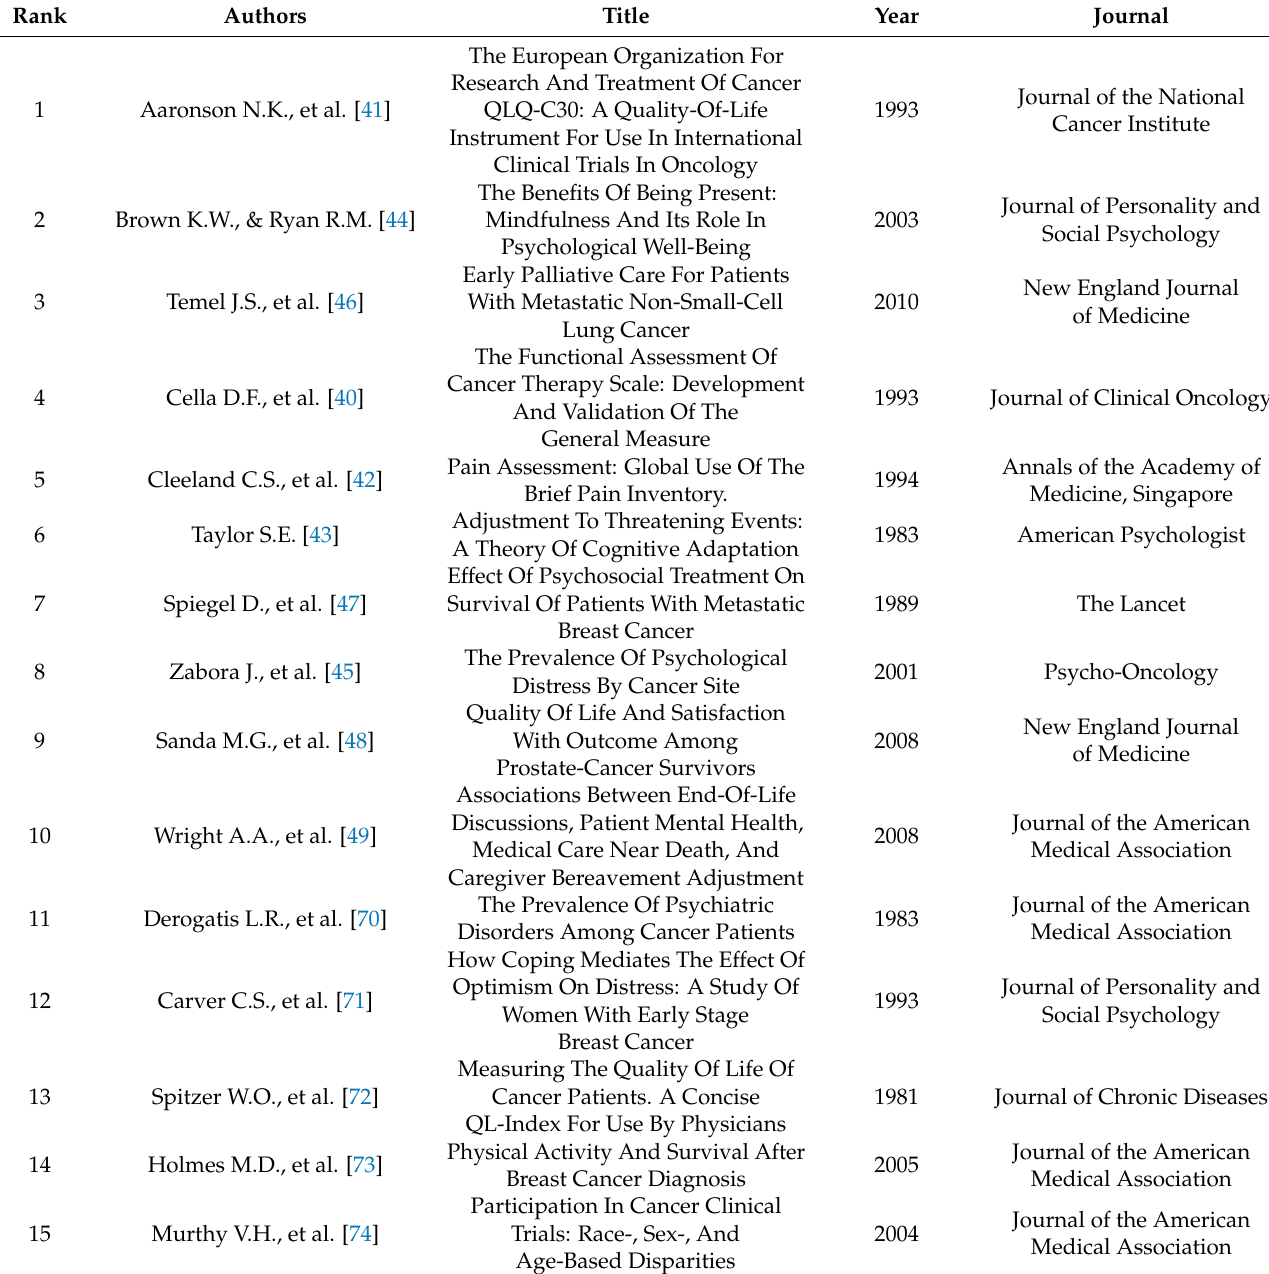
Table A1. Comprehensive results from Scopus for the 100 most cited journal